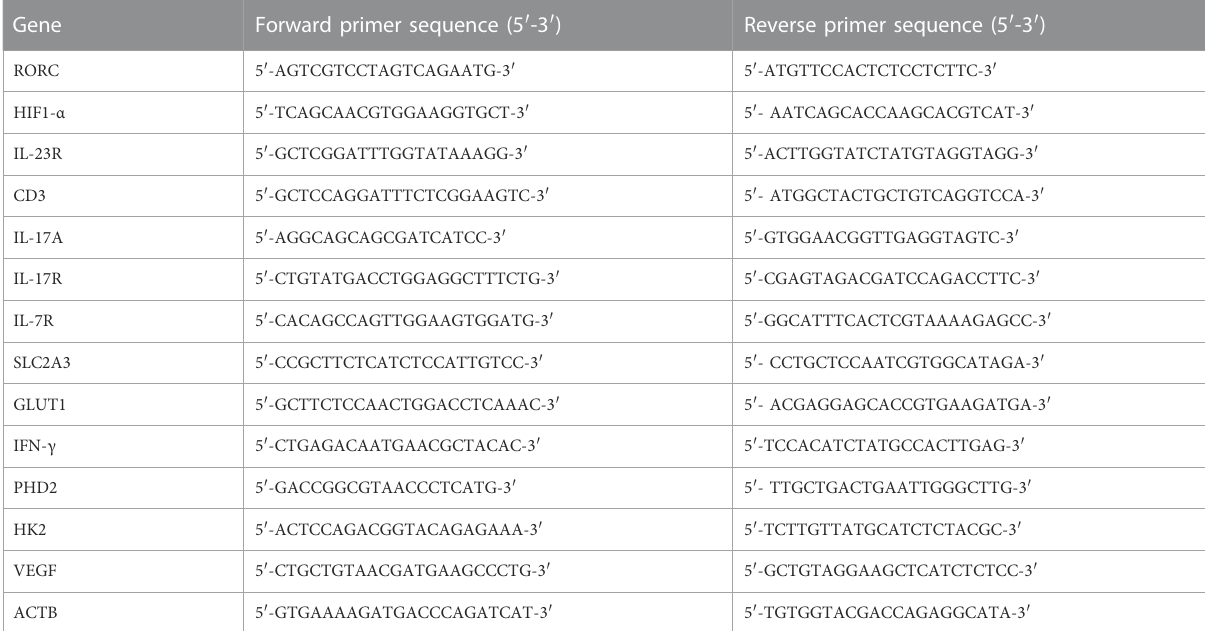
TABLE 1 The primer sequences used in this